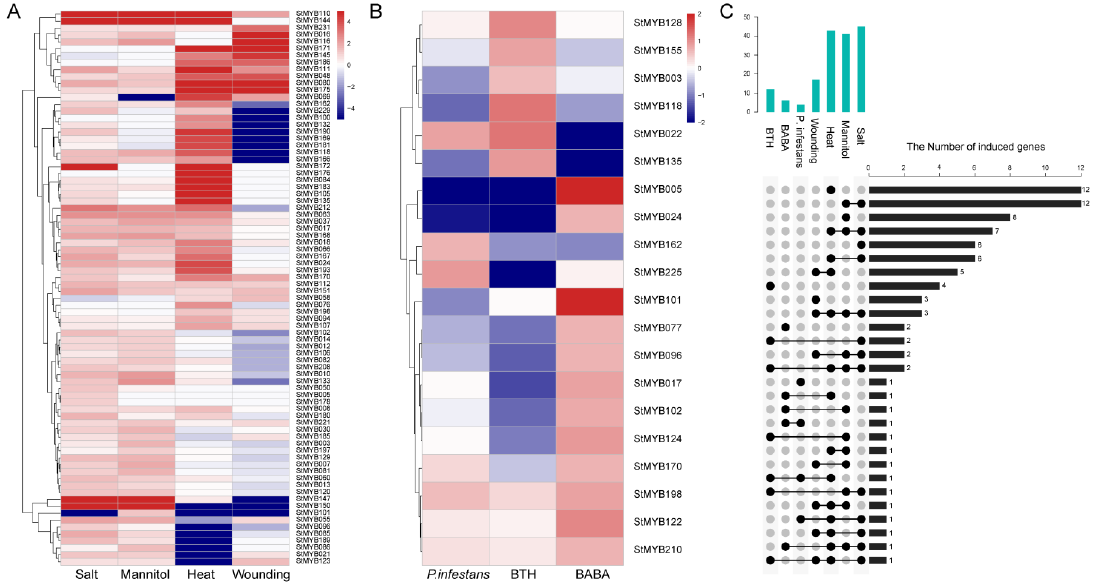
Figure 8. The expression patterns of StMYB genes under abiotic and biotic stress treatments. ( A ) The relative expression ratios of abiotic stress treatments; ( B ) the relative expression ratios of biotic stress treatments; ( C ) the summarized information of the stress-induced StMYB genes. The relative expression ratios of abiotic and biotic stress treatments were calculated relative to the untreated control, respectively, and then the significantly induced gene was defined to possess a log2 relative expression ratio ≥ 1 under one of the stress treatments. The red color, white color, and blue color represent the up-regulated, unaltered, and down-regulated expression, respectively.